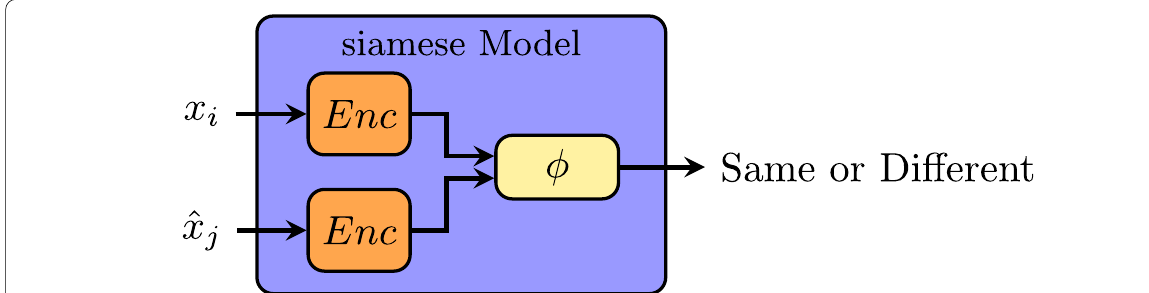
Fig. 2 Example of comparison between a reference ( x i ) and a new example ( ˆ x j ) from the query set, where Enc is the same network applied to both x i and ˆ x j . The model outputs the distance between the classes x i and ˆ x